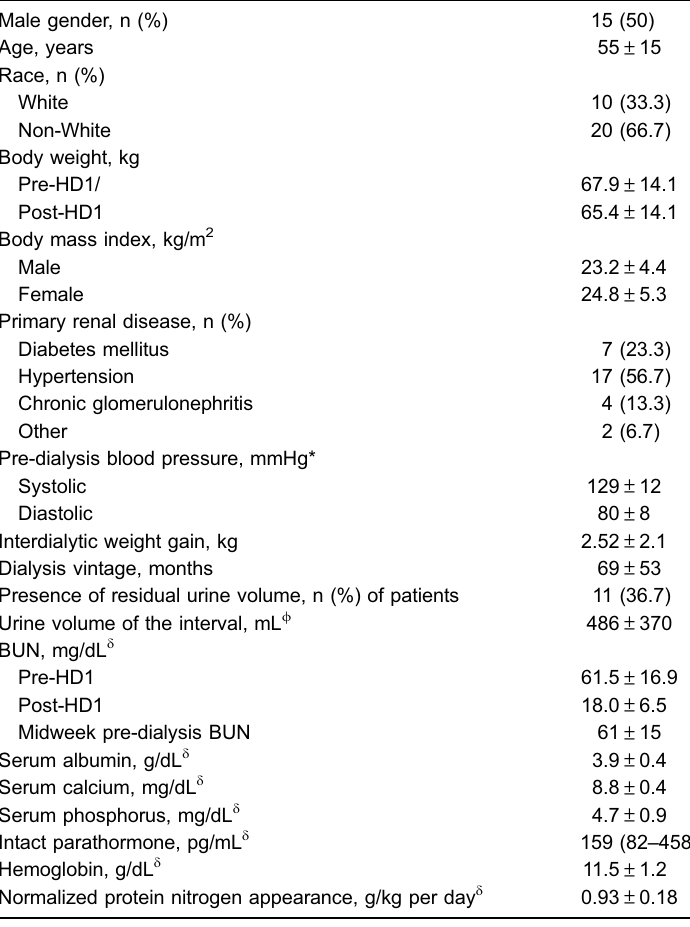
Table 2. General characteristics of